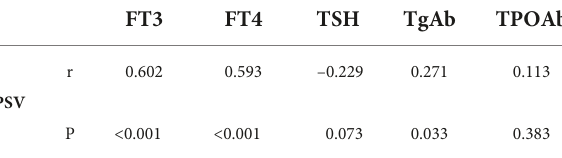
TABLE 3 Correlation between PSV of superior thyroid artery and serum indexes. FT3 FT4 TSH TgAb